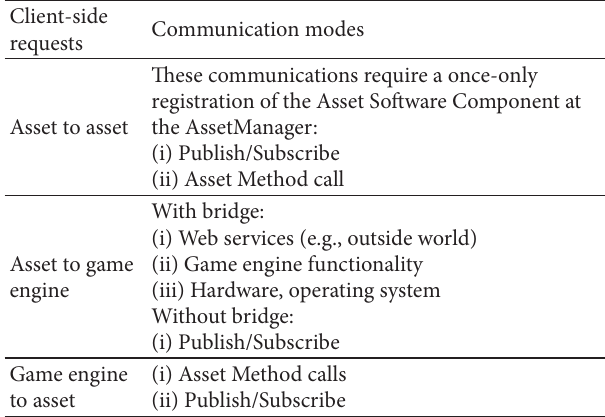
Table 1: Communication modes of client-side